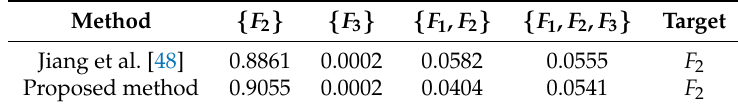
Table 10. Fusion results by using different combination methods at 1 X frequency.